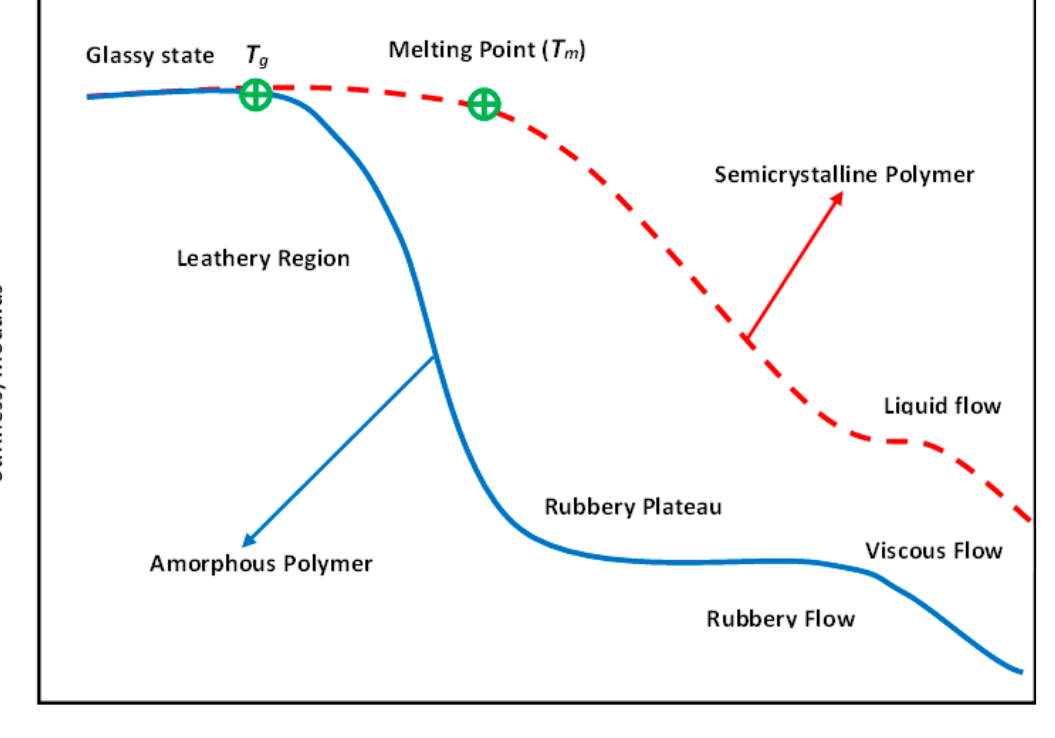
Figure 11. Melting and softening behavior of semi-crystalline and amorphous polymers. Figure 12 schematically depicts the level of energy generation versus time for a polymer-based structure due to phase lag between stress and strain over an entire cycle [49]. This corresponds to a hysteresis resulting from the viscoelastic response of a structure, which is schematically presented in Figure 13 with an indication of energy-based param- eters [11]. As can be vividly extracted from the diagram, the energy-based parameters can be categorized into storage and loss properties. The storage energy, which is proportional to storage modulus, can be explained when the cyclically loaded polymeric material is indeed unloaded, illustrated as the hatched area in Figure 13. From the other perspective, the elliptical area in Figure 13 (which has been obtained as the result of both loading and unloading over a cycle) is known as the loss energy, represented by a hysteresis loop, which is proportional to the loss modulus. To put it differently, if we connect the two vertices of the ellipse which form the major axis, the dynamic/complex modulus (overall viscoelastic performance) can be then defined and computed as the differences between the maximum and minimum response stresses divided by the differences between the maximum and minimum applied strains over a cycle. This parameter consists of both storage and loss moduli. Thus, the lower boundary of the hysteresis loop can locally